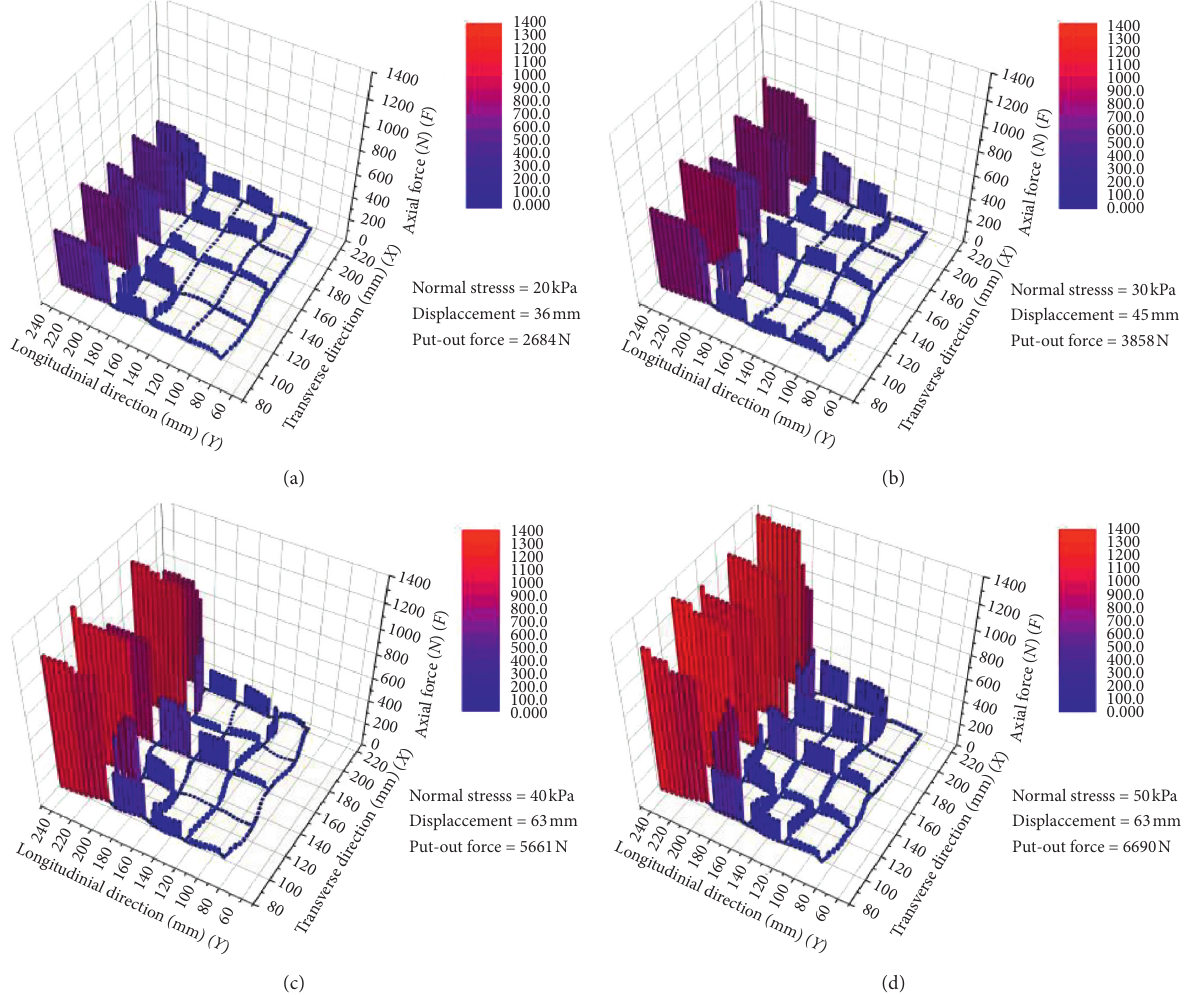
Figure 6: Axial force distribution of BG1 under peak pull-out force: comparison of different normal